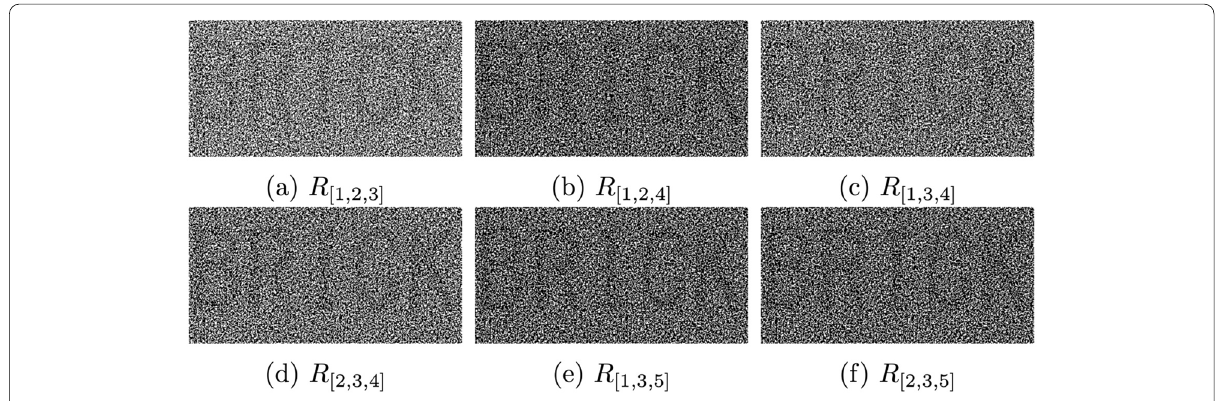
Fig. 6 Reconstructed images that have the same value of ˜ α 3 = 0.0625